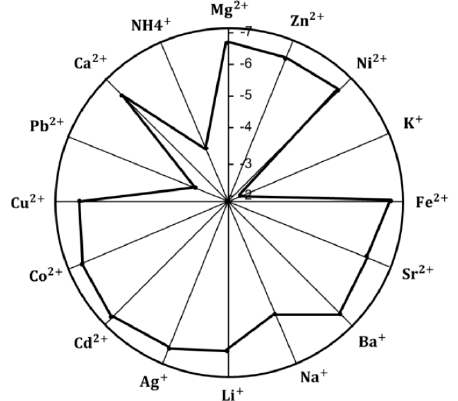
Figure 4. Selectivity coe ffi cient (Log k pot ) values of the proposed sensor using modified separate Figure 4. Selectivity coefficient ( Log k (cid:2904)(cid:2922),(cid:2894)(cid:2926)(cid:2925)(cid:2930) ) values of the proposed sensor using modified separate Tl,J Figure 4. Selectivity coefficient ( Log k (cid:2904)(cid:2922),(cid:2894)(cid:2926)(cid:2925)(cid:2930) ) values of the proposed sensor using modified separate solution method solution method (MSSM). solution method (MSSM). Figure 4. Selectivity coefficient ( Log k (cid:2904)(cid:2922),(cid:2894)(cid:2926)(cid:2925)(cid:2930) ) values of the proposed sensor using modified separate solution method (MSSM).